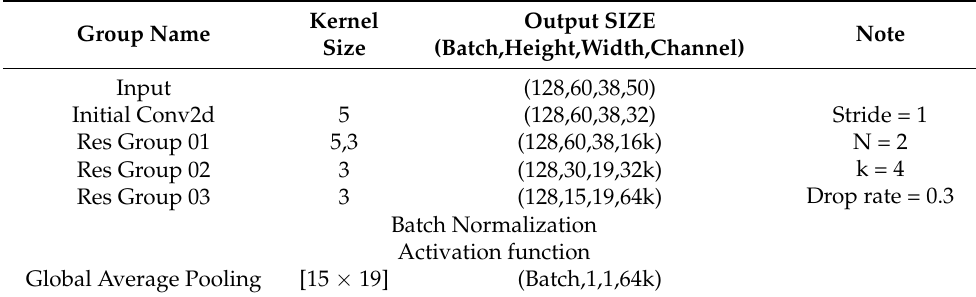
Table 3. Modified Wide Resnet structure and kernel size.